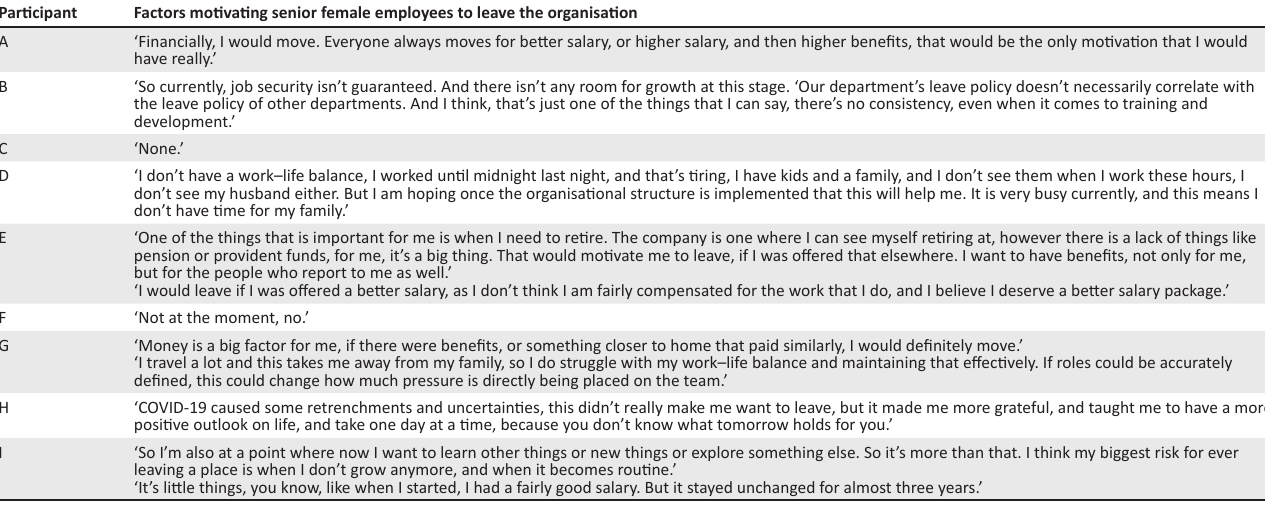
TABLE 4: Factors motivating employees to leave the organisation. Participant Factors motivating senior female employees to leave the